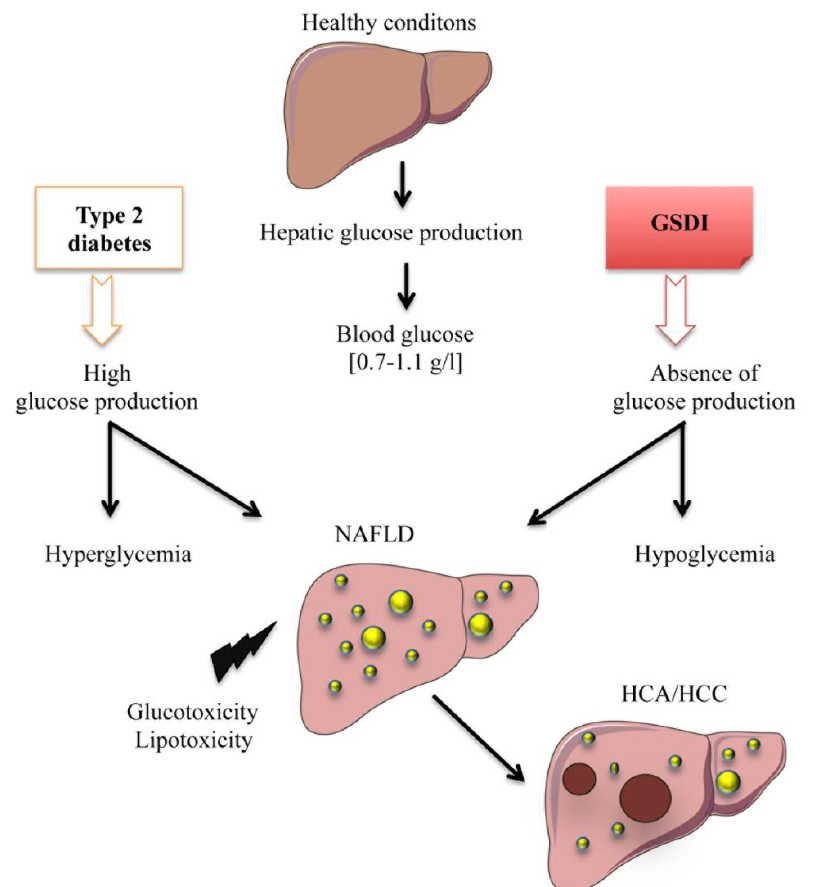
FIGURE 1: Deregulation of endoge- nous glucose production leads to hepatic complications. In normal physiological conditions, the liver maintains glucose homeostasis in the blood by releasing free glucose during fasts and by up-taking and storing excessive glucose during post-prandial periods. In type 2 diabetes, hepatic production and uptake of glucose is deregulated, resulting in hyperglyce- mia. In Glycogen Storage Disease type I (GSDI), glucose production in